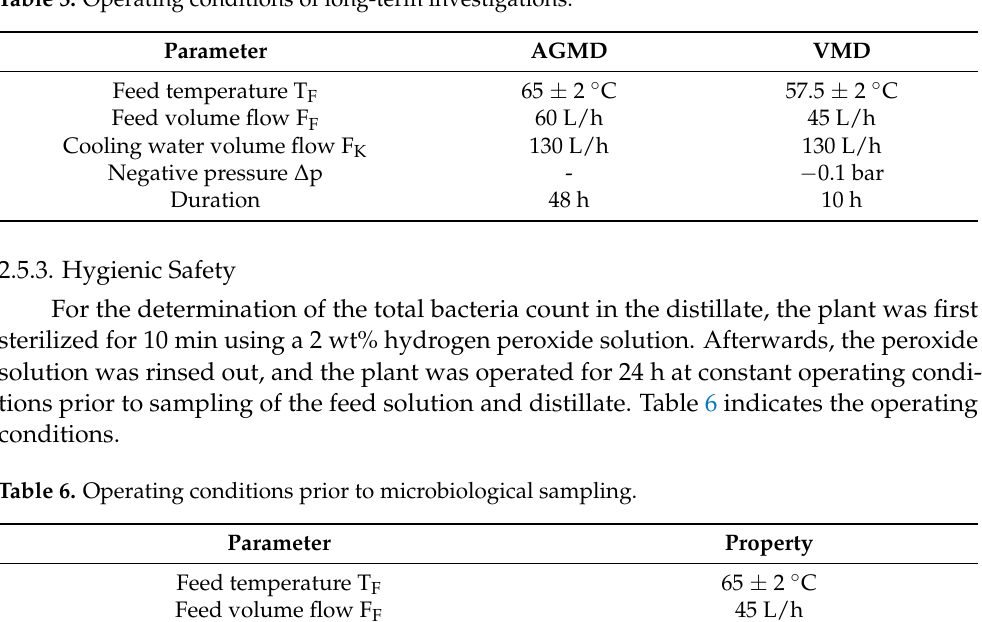
Table 5. Operating conditions of long-term investigations.